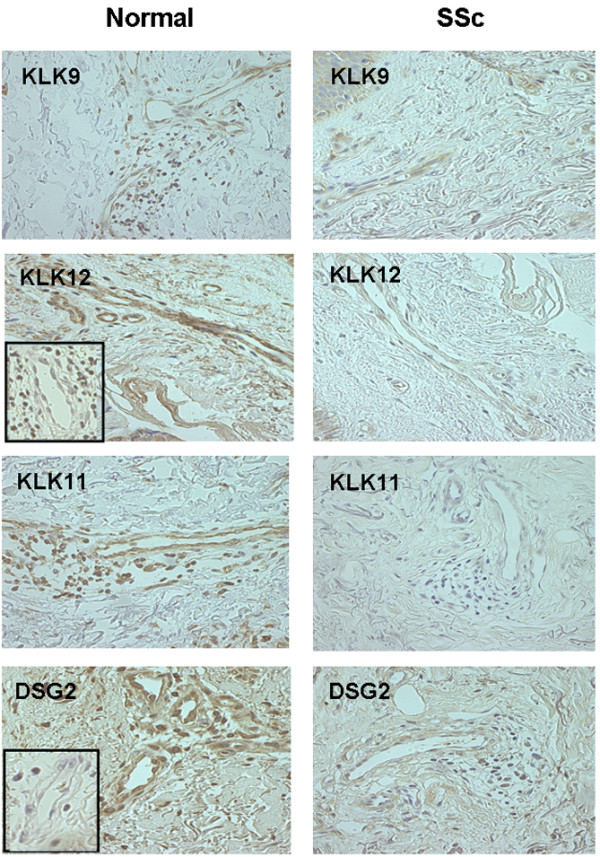
Immunohistochemical evidence of differential expression of tissue kallikrein (KLK)9, KLK11, KLK12, and DSG2 in microvascular endothelial cells (MVECs) from normal subjects and patients with systemic sclerosis (SSc). Each panel is representative of the pattern of immune staining with each antibody obtained for the six normal and six SSc patients subjected to skin biopsies from which MVECs were prepared. The inset in the micrograph of KLK12 shows negative staining using isotype control rabbit IgG (the isotype used for KLK9 and KLK12), while that shown in the micrograph of DSG shows negative staining for mouse IgG (the isotype used for KLK11 and DSG). Original magnification, 200×.